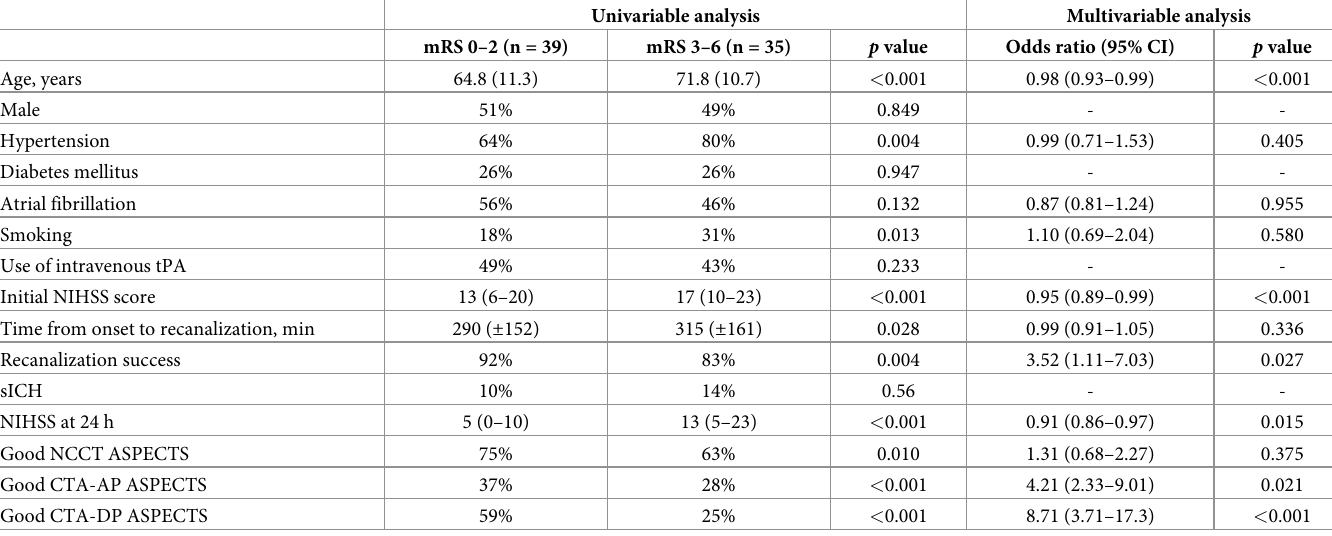
Table 2. Univariable and multivariable analyses for favorable